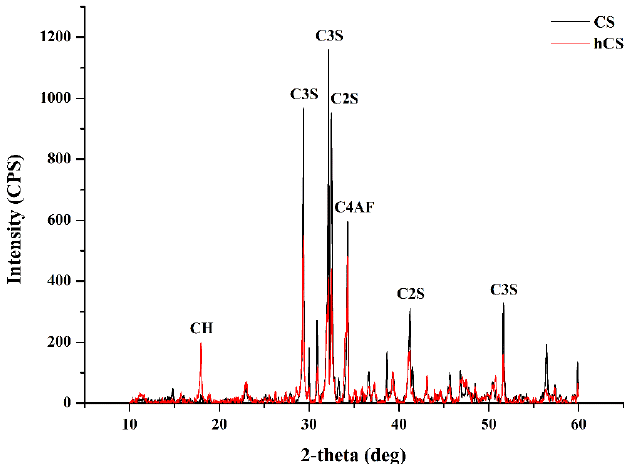
Figure 1. X-ray diffraction patterns of the non-hydrated CS powder (black line) and hydrated CS powder (red line) stored in distilled water. CH, calcium hydroxide; C3S, tricalcium silicate; C2S, bicalcium silicate; C4AF, tetracalcium aluminoferrite.